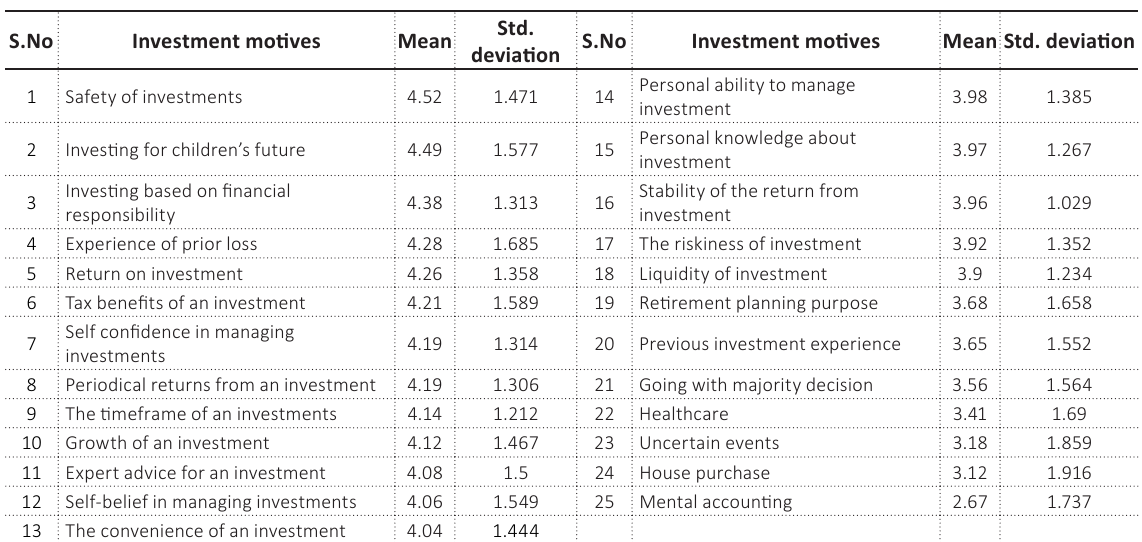
Table 1. Mean response to various investment